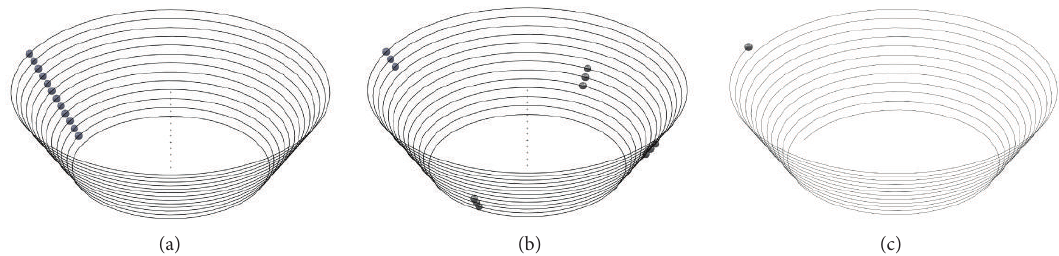
Figure 3: The three different trajectories used for the produced parts (a) V1, (b) V2, and (c) V3.